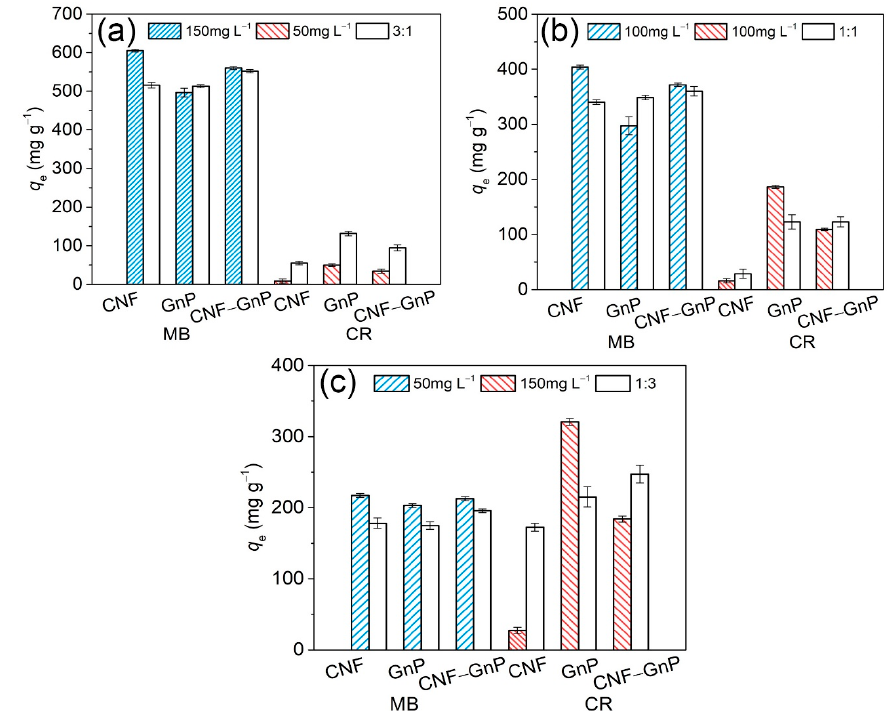
Figure 7. Adsorption of MB and CR in single and binary dye solution. ( a ) mass ratios of MB to CR are 3:1; ( b ) mass ratio of MB to CR are 1:1; ( c ) mass ratio of MB to CR are 1:3. Colored bars represent adsorption in a single dye system. Colorless bars represent adsorption of one dye in a binary dye